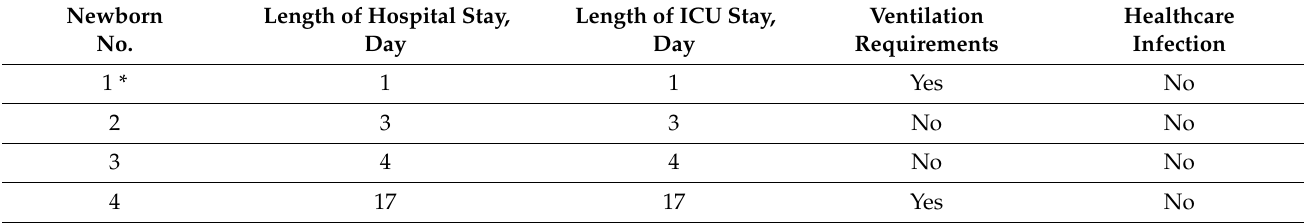
Table 4. Outcomes of the neonates isolated in the negative-pressure